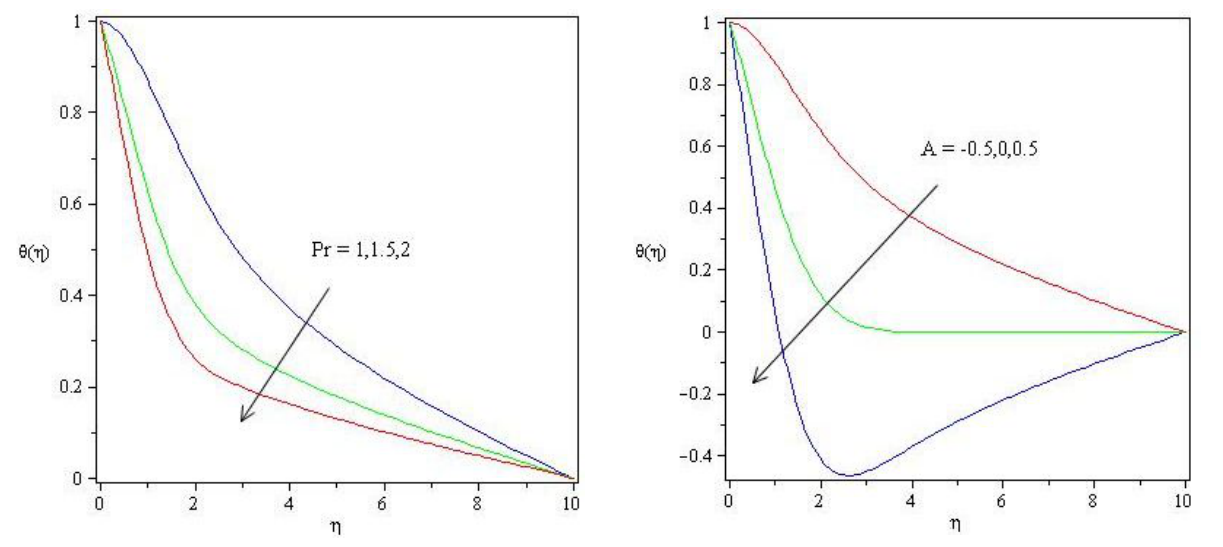
source/sink parameter and temperature dependent heat source/sink parameter. And Fig. 20 shows the profile for wall temperature parameter as increasing the power law index p which reduces the temperature in the boundary layer. Fig. 21 and 22 plotted for temperature profile different values of moving parameter λ and velocity slip parameter β . As increasing the moving parameter λ which increases the thickness of the thermal boundary layer and velocity slip parameter β also shows that the same effects of ther- mal boundary layer. Fig. 23, 24 and 25 directed for the temperature gradi- ent profile for various values of the physical parameters such as moving parameter, velocity slip and temperature slip parameters respectively. Here some points of effects of these physical parameters are found as, as increasing the values of moving parameter and velocity slip param- eter the temperature gradient increases and temperature gradient decreases as increasing the temperature velocity parameter.